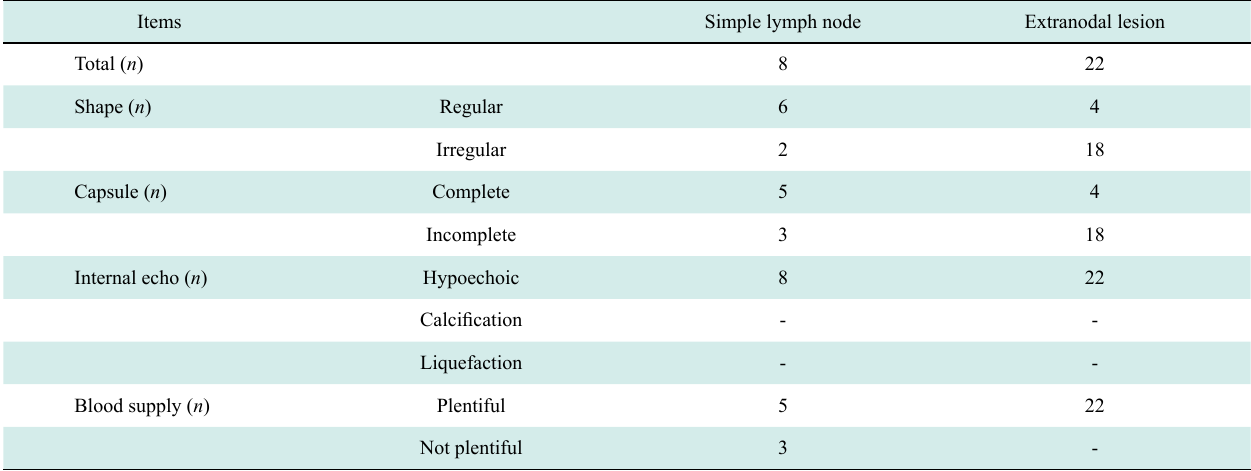
Table 2 Ultrasound imaging features of Kimura disease